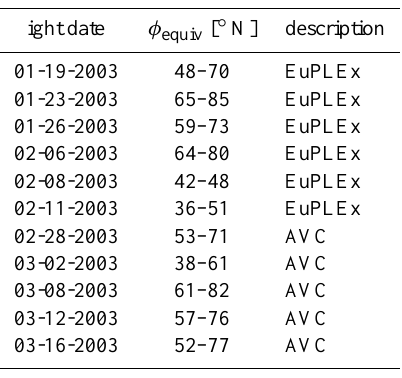
Table 1. Data description of the tracer data plotted in Fig. 2, pro- viding flight date, the range of equivalent latitude φ equiv and the campaign